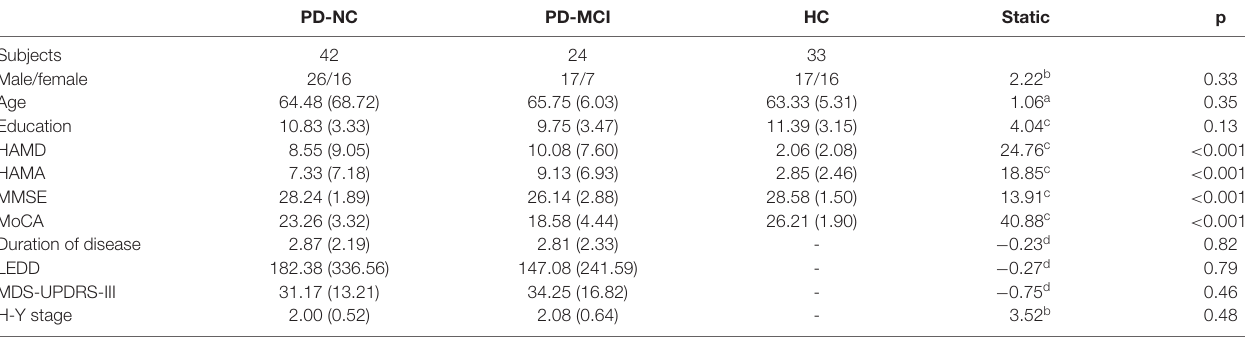
TABLE 1 | Demographic and neuropsychological